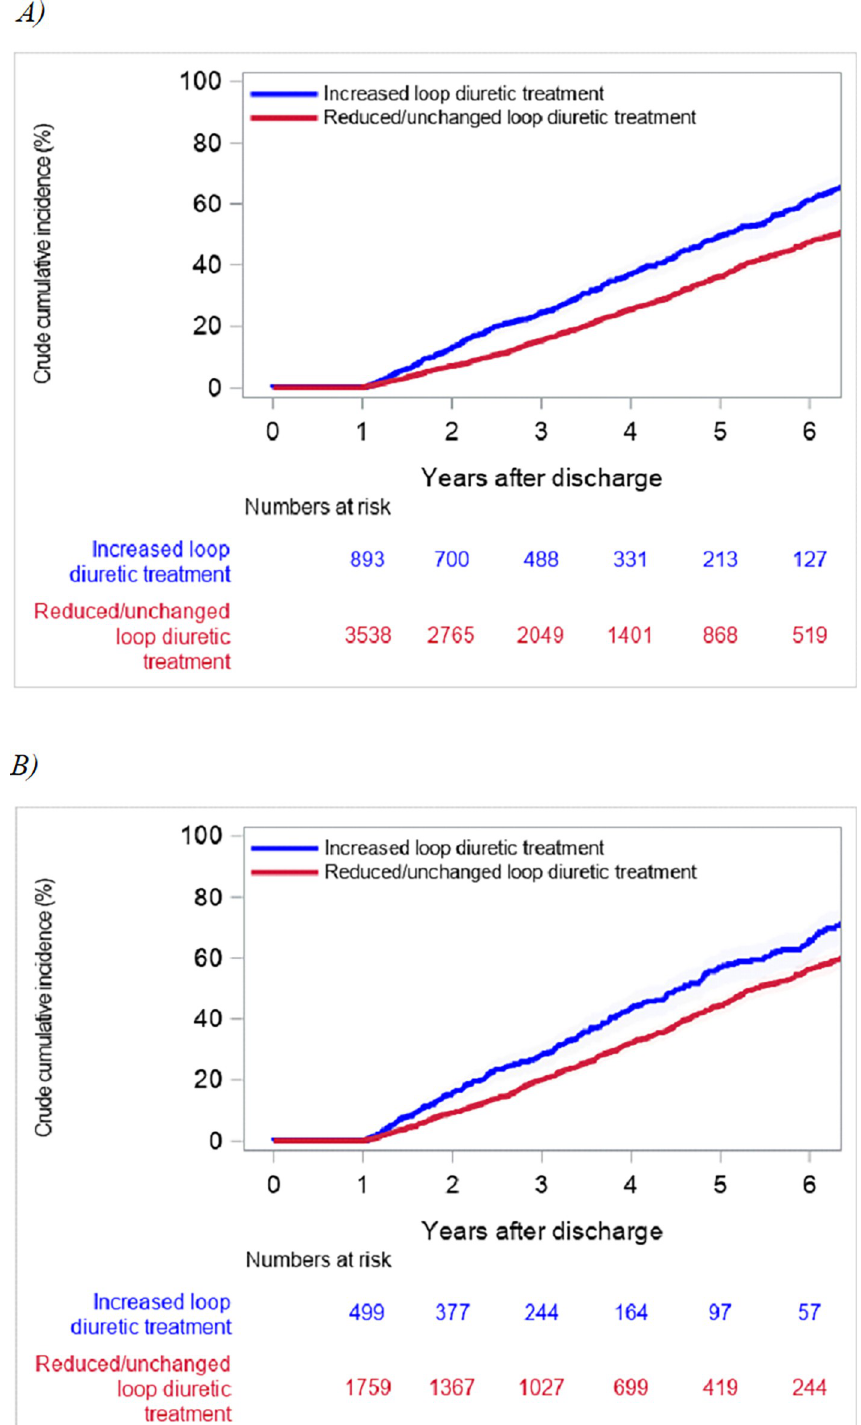
Fig 3. Cumulative incidence of death among patients alive one year after discharge for TAVI procedure with increased and reduced/unchanged loop diuretic treatment at 1-year post-TAVI. A) Patients alive one year after discharge for TAVI procedure. (B) Patients alive one year after discharge for TAVI procedure, excluding patients with no loop diuretic treatment pre-procedure. Abbreviations : TAVI , transcatheter aortic valve implantation .